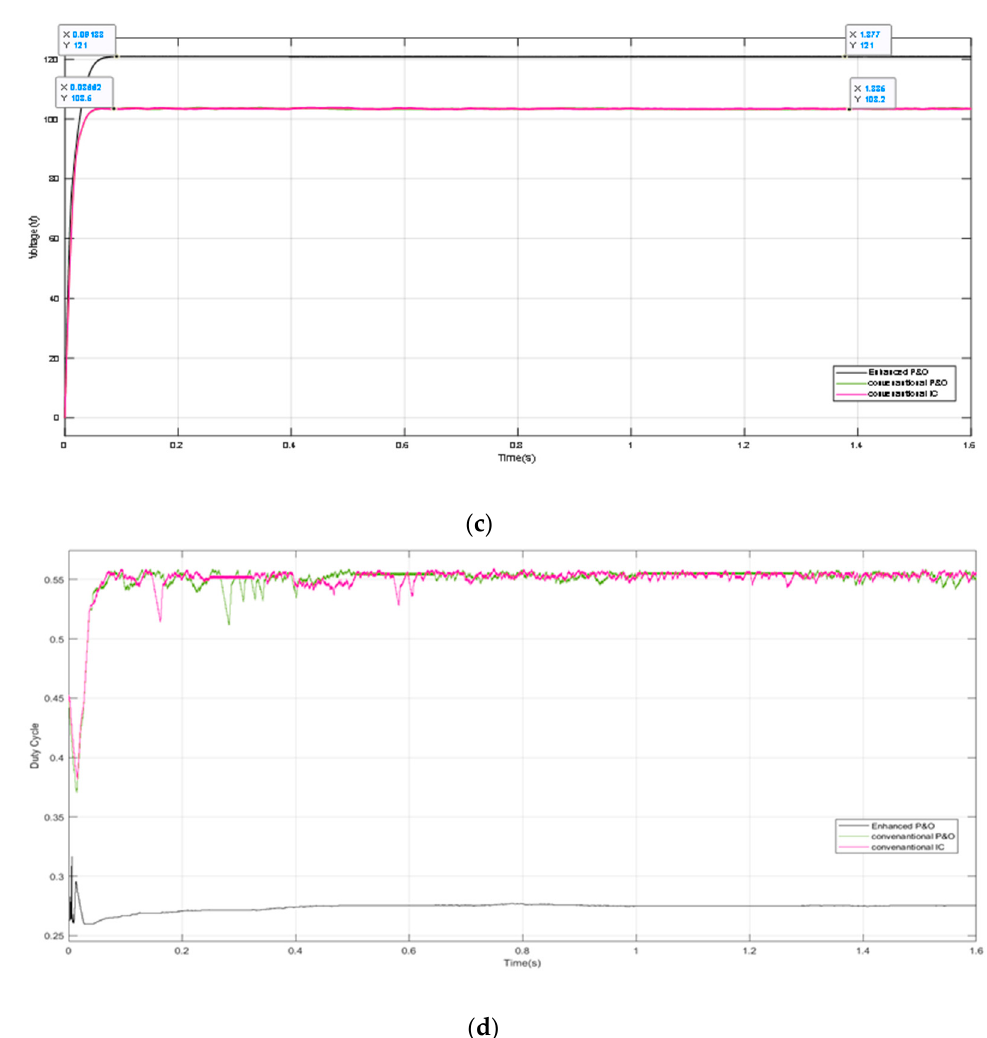
Figure 18. ( a ) Scenario of case “b” of the (8S) PV array; ( b ) The extracted power by the proposed technique and the conventional P&O and IC techniques; ( c ) The voltage at the boost converter output; ( d ) The duty cycle behaviors.